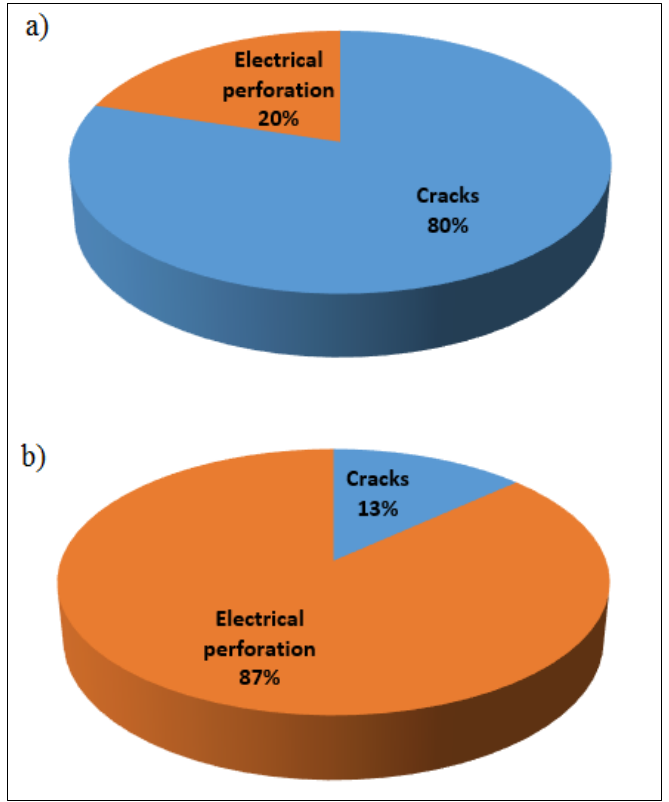
Figure 5: Cause of rejection percentages: a) rigid covers, b) flexible conductor